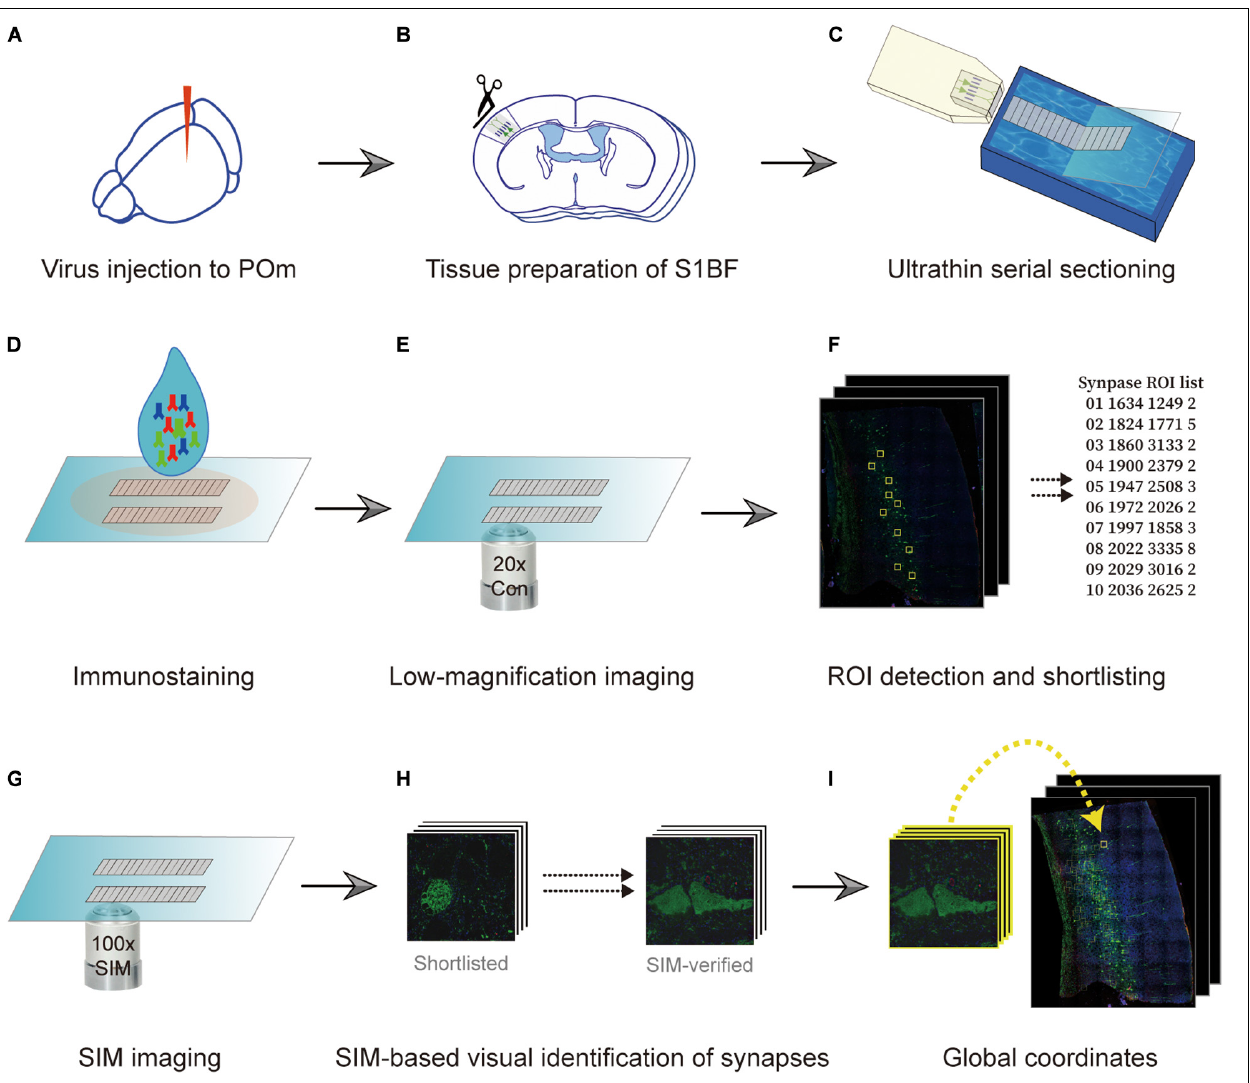
FIGURE 1 | Overview of the imaging technique. (A) Fluorescence labeling of synapses-of-interest. Neurons in the posteromedial nucleus of the thalamus (POm) were labeled using stereotactically delivered adeno-associated virus (serotype 1) transduction of tdTomato in a Thy1-EGFP (type M) mouse. After 4 weeks, the mouse was sacrificed and fixed with 4% paraformaldehyde. (B) Embedding. Subsequently, the S1BF region was embedded in Lowicryl resin. (C,D) Serial sectioning and immunostaining. A series of 90 nm sections were collected (C) and immunostained with antibodies against synaptophysin-1, GFP, and tdTomato (D) . (E,F) Low-magnification imaging and ROI detection. The series of sections were imaged at 20x resolution, and the global coordinates of ROIs were computed based on the existence of overlapping color channels. (G) SIM imaging. ROIs were revisited, and SIM images of the regions were acquired. (H,I) Determination of synapse locations. SIM images were post-processed to render the synapse images and visually determine if the structure indeed formed synapses (H) . True synapses were relocated on the low-magnification image with image registration (I)